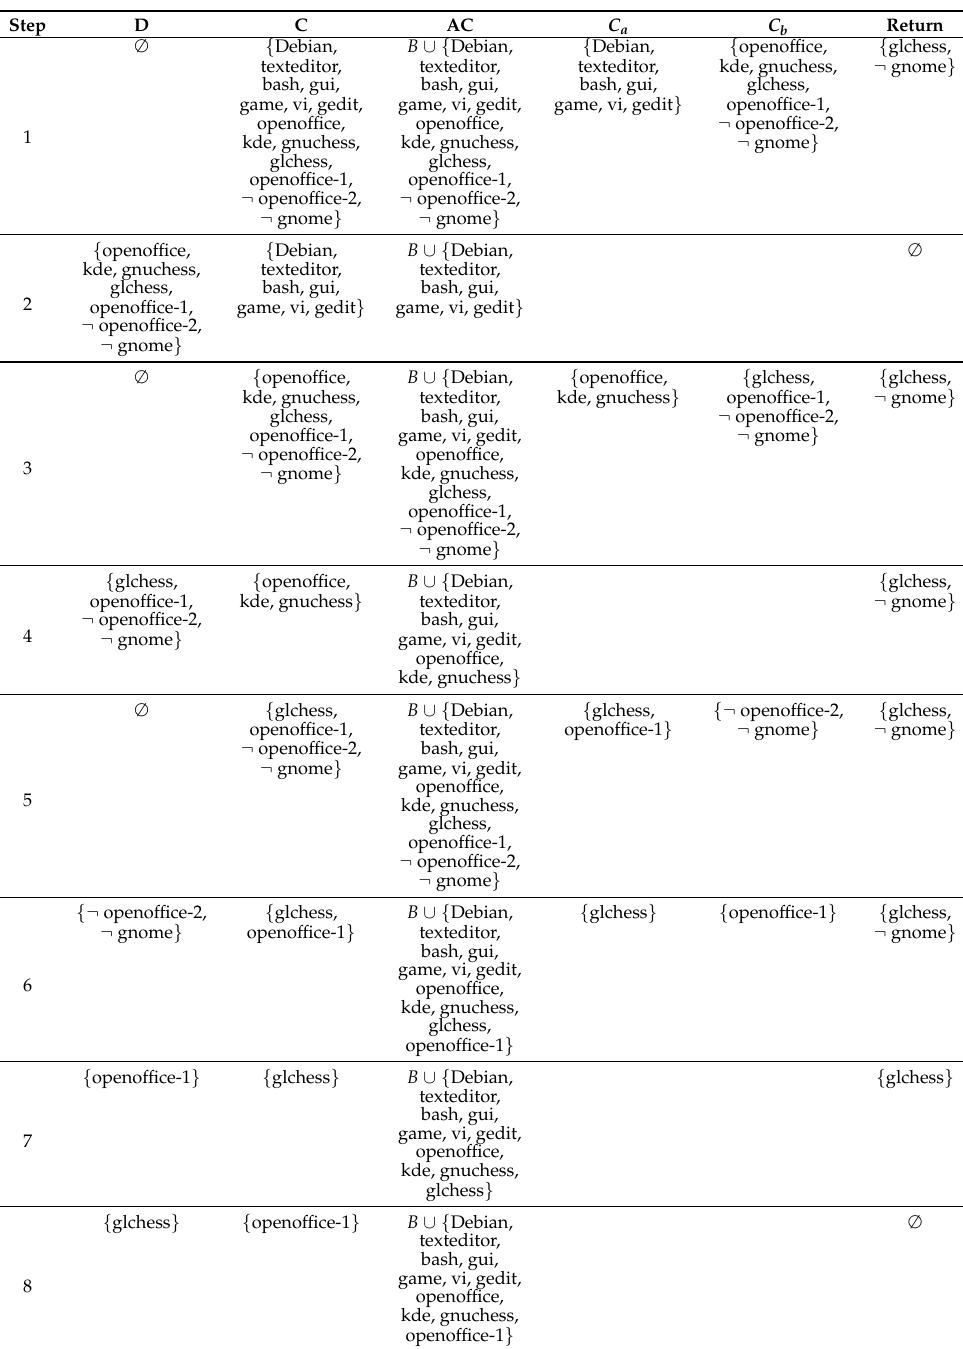
Table 7. Tracking of the F AST D IAG execution on configuration example of Figure 7 (part